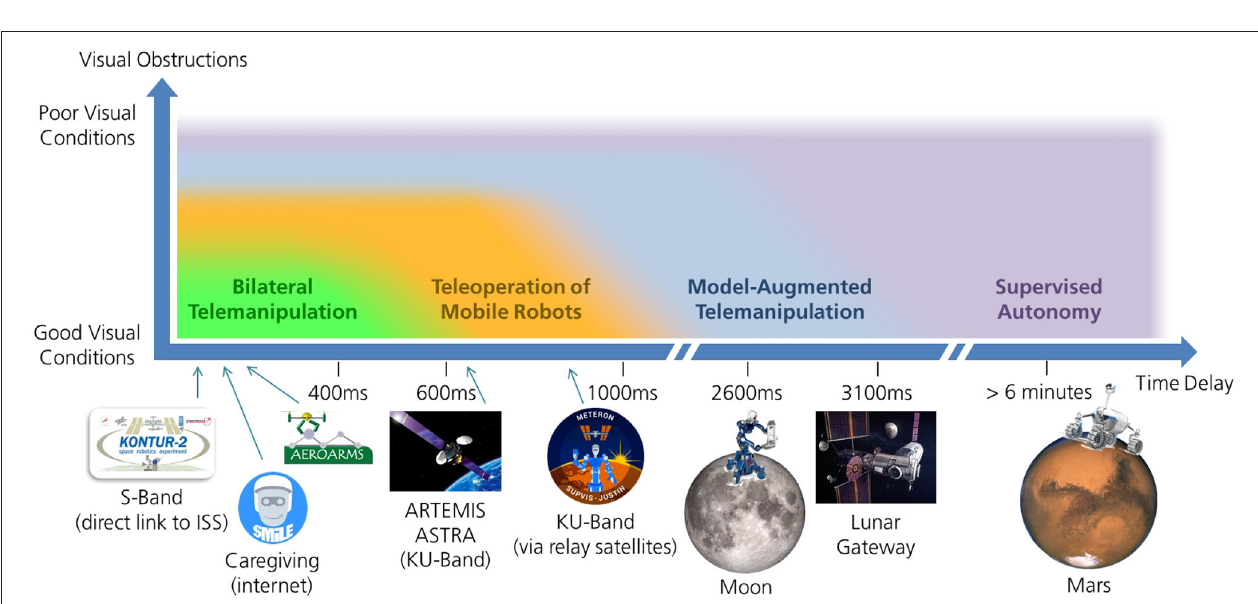
Frontiers in Robotics and AI |